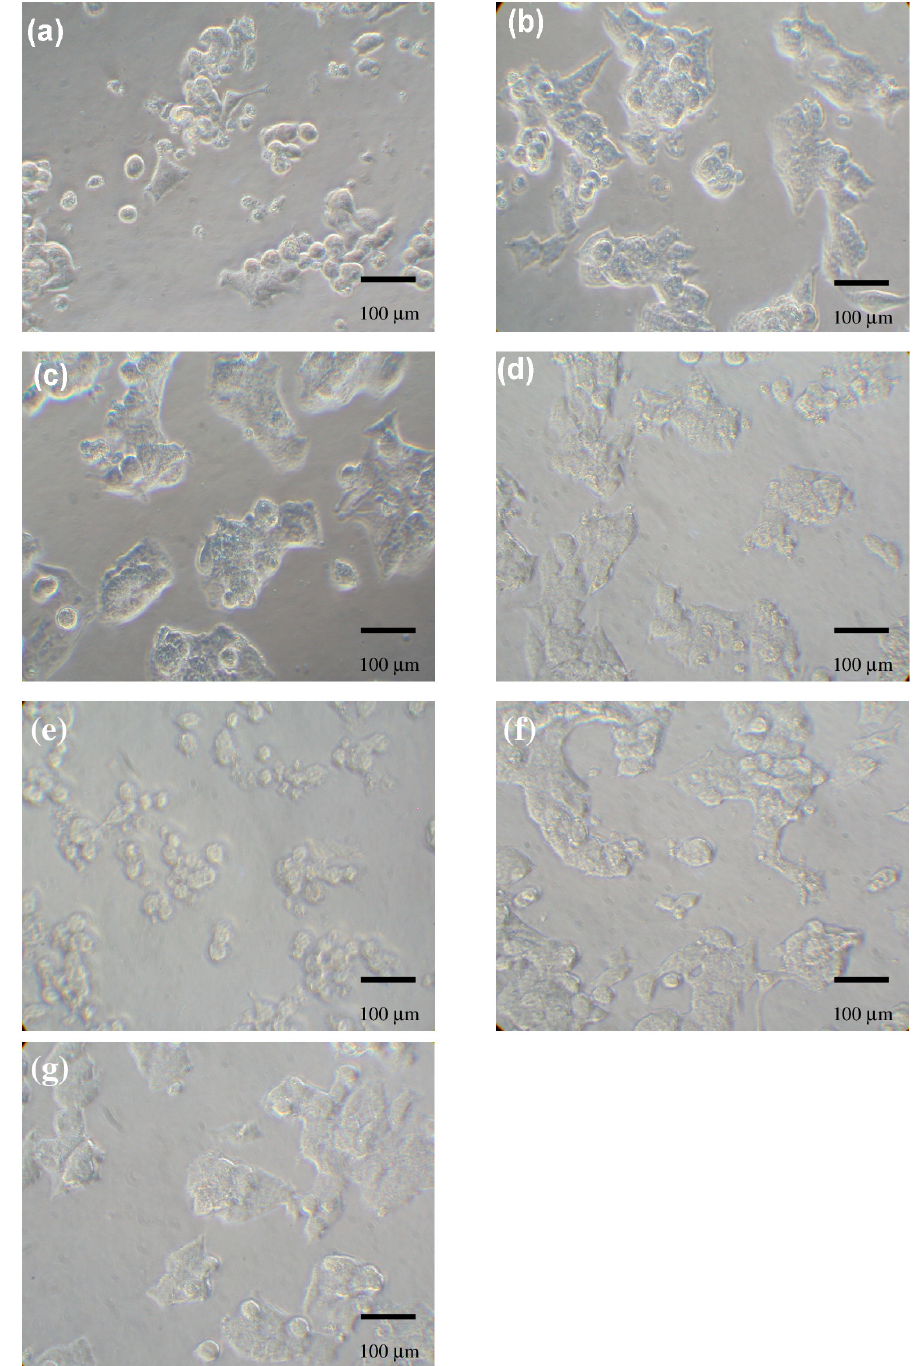
Fig 2. Morphology of Hep G2 cells treated with ACE/CS. Cells at a density of 2.0 × 10 5 cells/well were incubated in medium containing (a) 21.2 μ g/mL, (b) 10.6 μ g/mL, (c) 5.3 μ g/mL, and (d) 2.65 μ g/mL ACE/CS for 48 h and observed by phase contrast microscopy (200×). Cells incubated with 100 μ g/mL Trail (e) and without treatment (f) were defined as positive controls and controls, respectively. The nanoparticles without ACE polysaccharides (g), CSNP (667 μ g/mL) were also examined. Each experiment (n = 3) was repeated 3 times independently to ensure reproducibility. ACE/CS: ACE polysaccharides encapsulated by chitosan- silica nanoparticles; ACE: A . camphorata extract; CSNP: chitosan-silica nanoparticles.